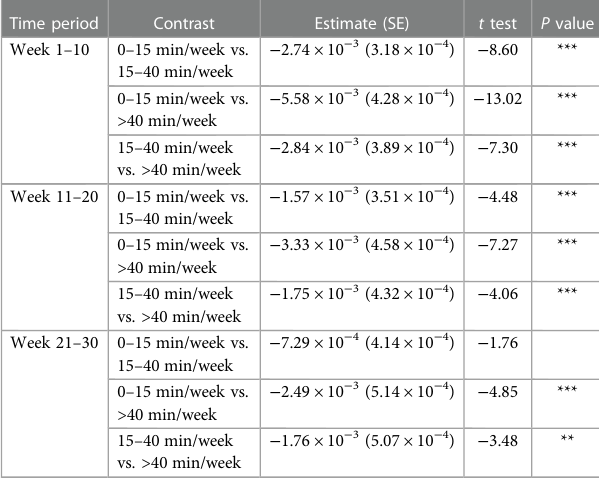
TABLE 8 Pairwise comparisons of slopes by dosage amount group (variable